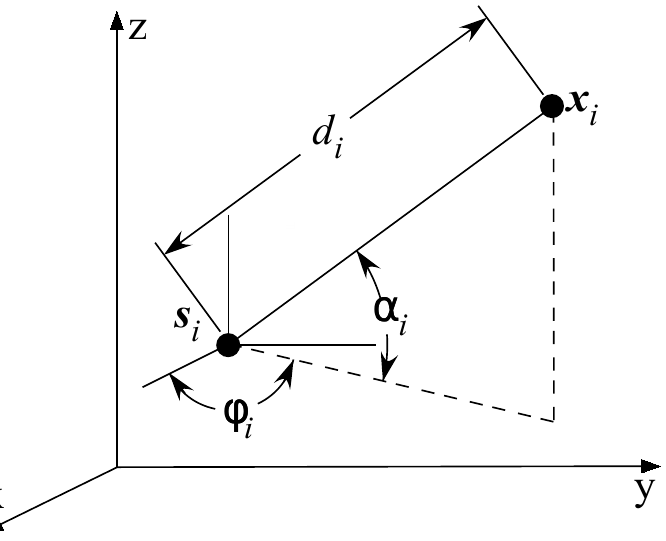
Figure 1. Illustration of a target and anchor in three-dimensional space, and the distance and bearing information between